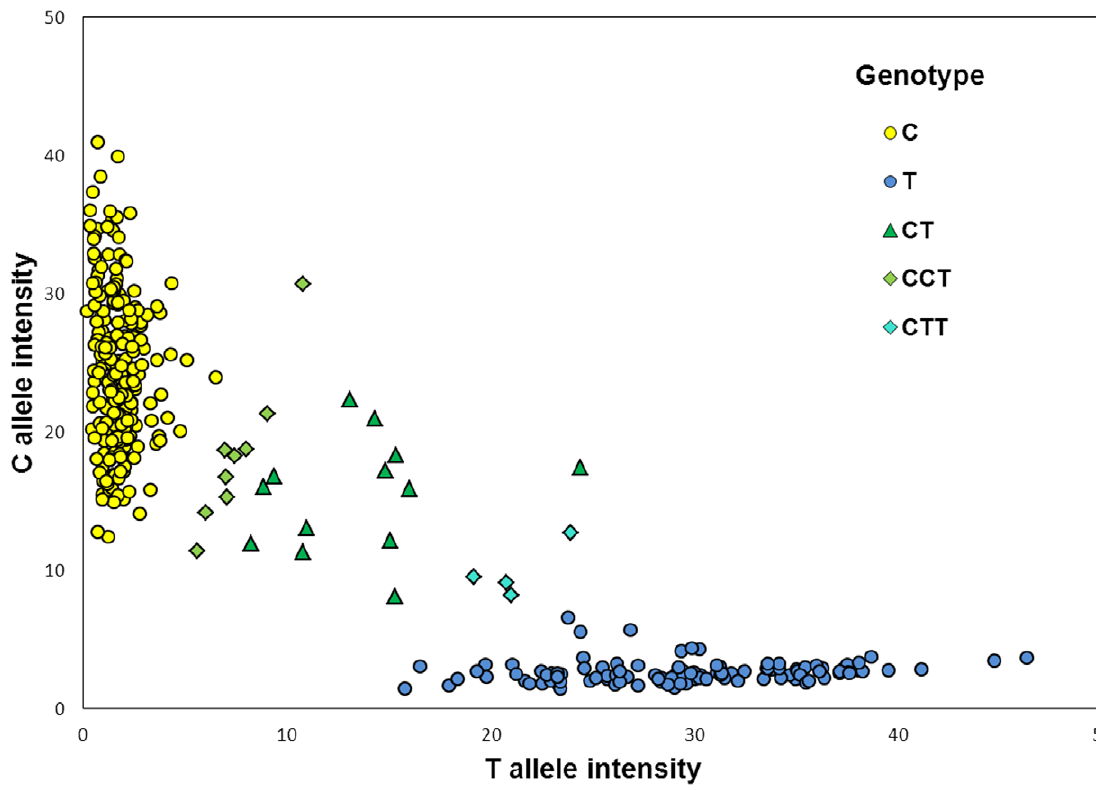
Figure 3. Genotyping result obtained for the locus ‘‘harma_c3117_1457’’ in the dataset of 380 samples (from 80 localities). Single- allele infections are represented with filled circles (C and T genotypes) whereas probable mixed-allele infections are represented with triangles, crosses and stars. CCT and CTT allele combinations were considered respectively as C and T when considering ‘‘high level of co-infection’’ or conservatively as C and T, for analyses mentioned as ‘‘low level of co-infection’’.